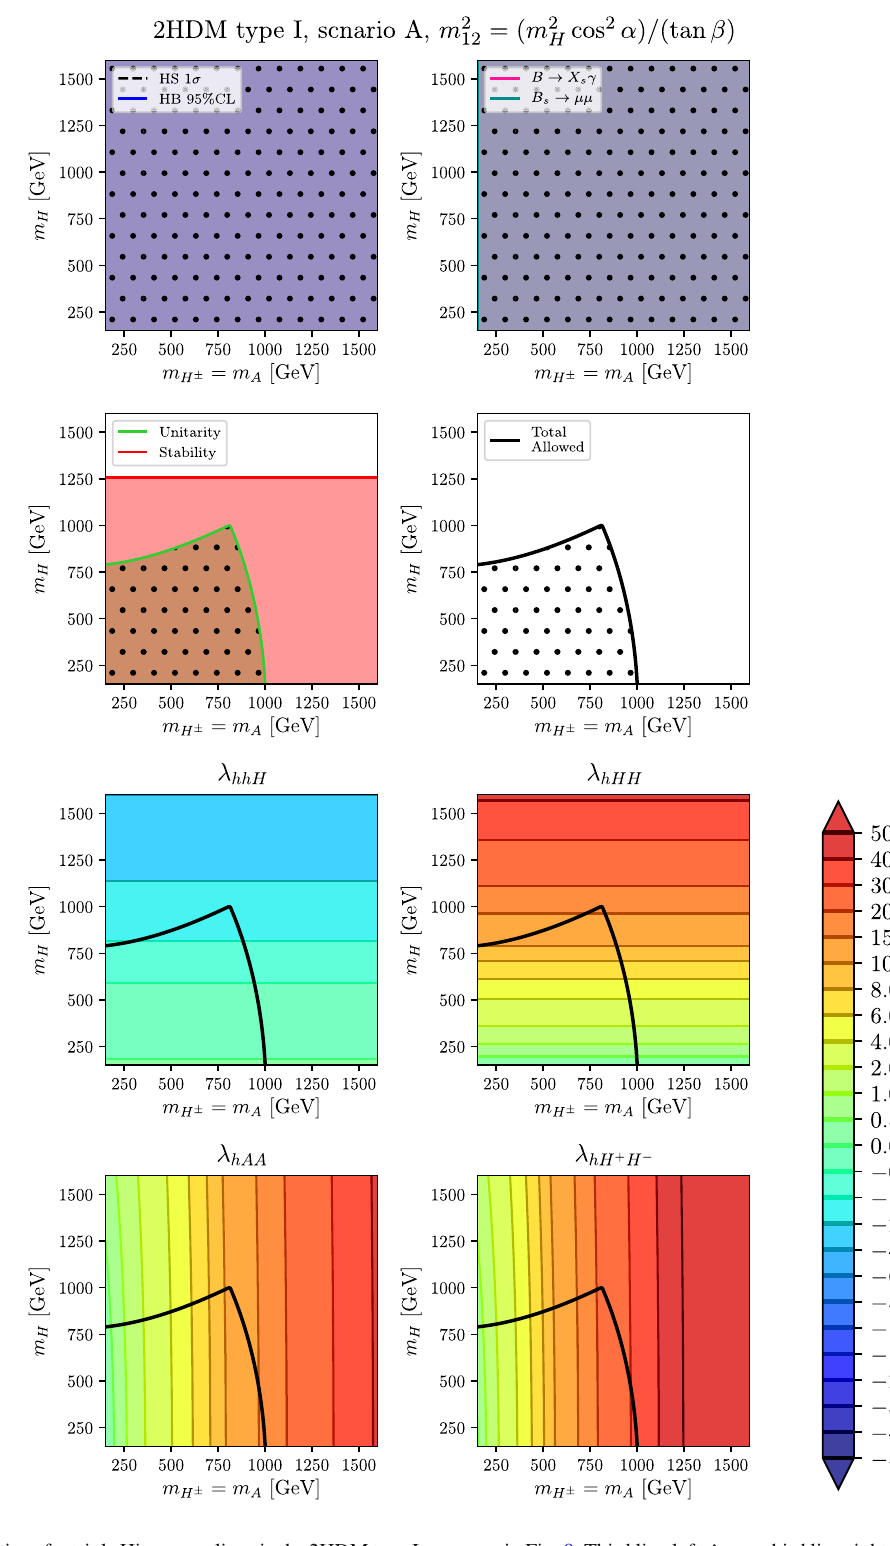
in Fig. 8. Third line left: λ hhH , third line right: λ hHH , lower left: λ hAA , lower right: λ hH + H